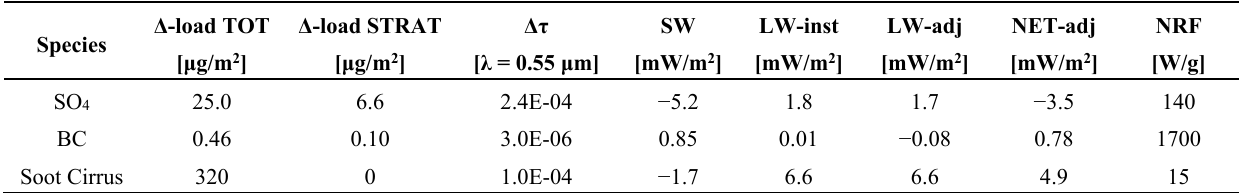
Table 6. Summary of aerosol Radiative Forcing mean values: direct contributions from sulphate and soot (BC) and indirect BC forcing (soot-cirrus) (AE*-NA): ULAQ-CTM values and ULAQ radiative code. Here Δτ is the particle optical thickness perturbation at λ = 0.55 μ m. The final column shows the normalized RF ( i.e. , absolute value of the net-RF divided by the globally averaged Δ - load).